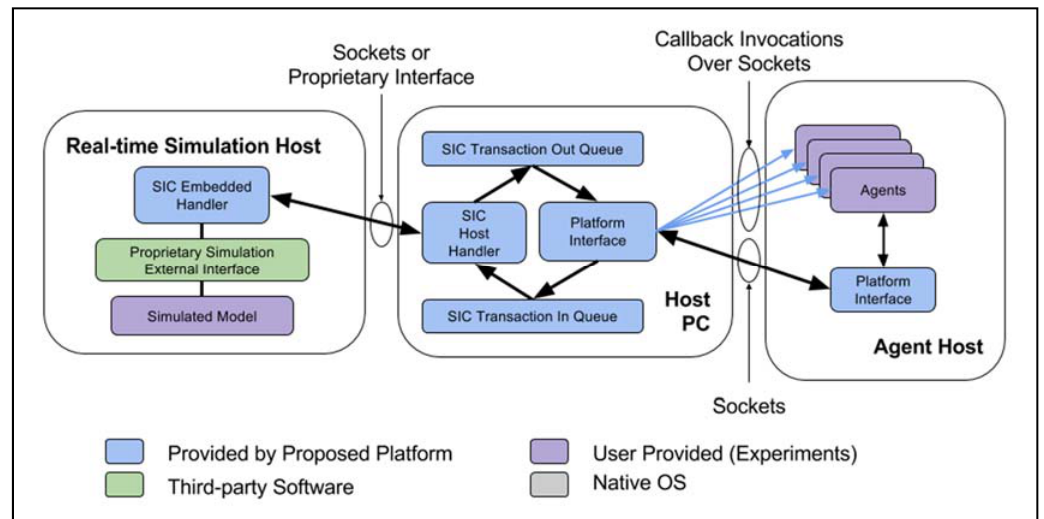
Figure 3. Case 1 Test Environment.